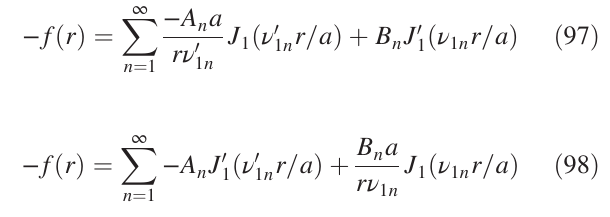
profile in terms of the paraxial TE-TM modes in region 1. TABLE II. Comparison of the diffraction loss ( L ) results